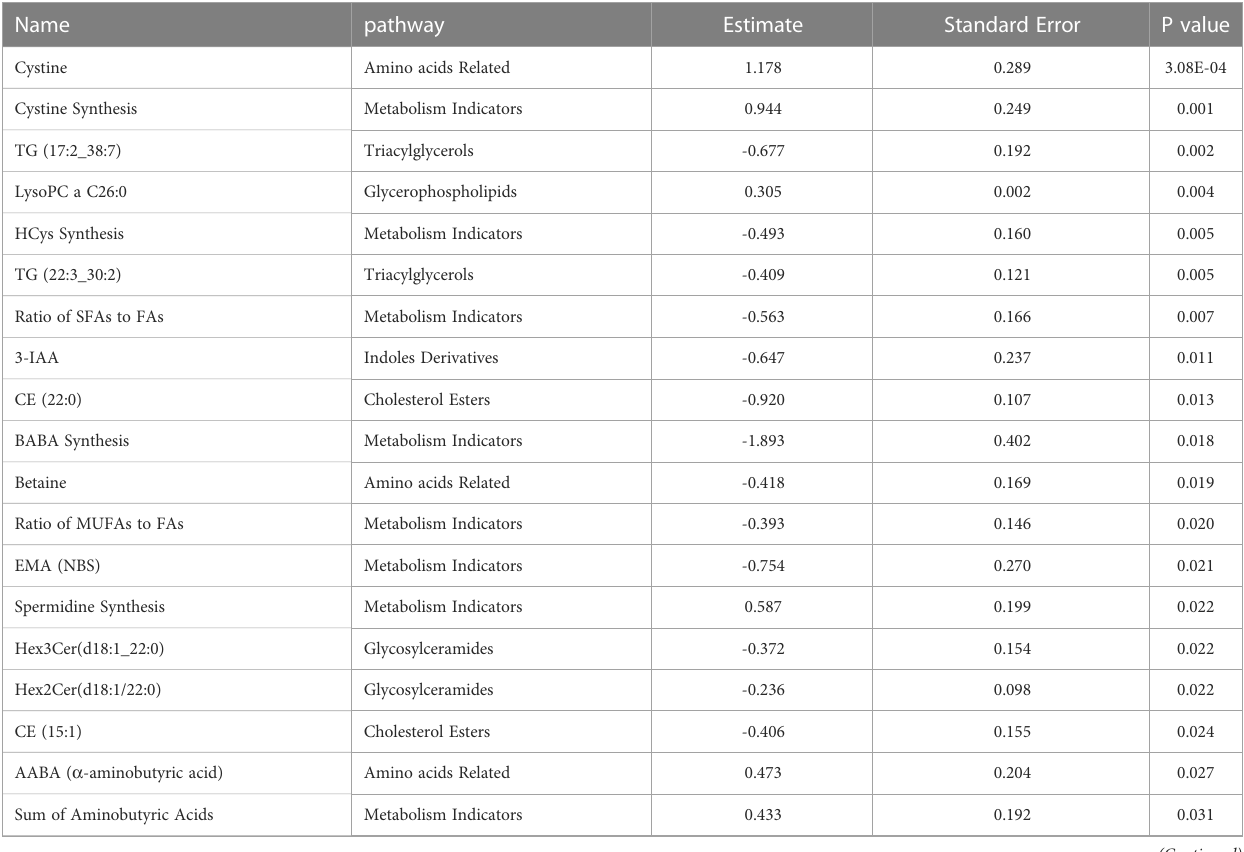
TABLE 3 Metabolites associated with BCG vaccination in non-diabetic patients with COVID-19. Name